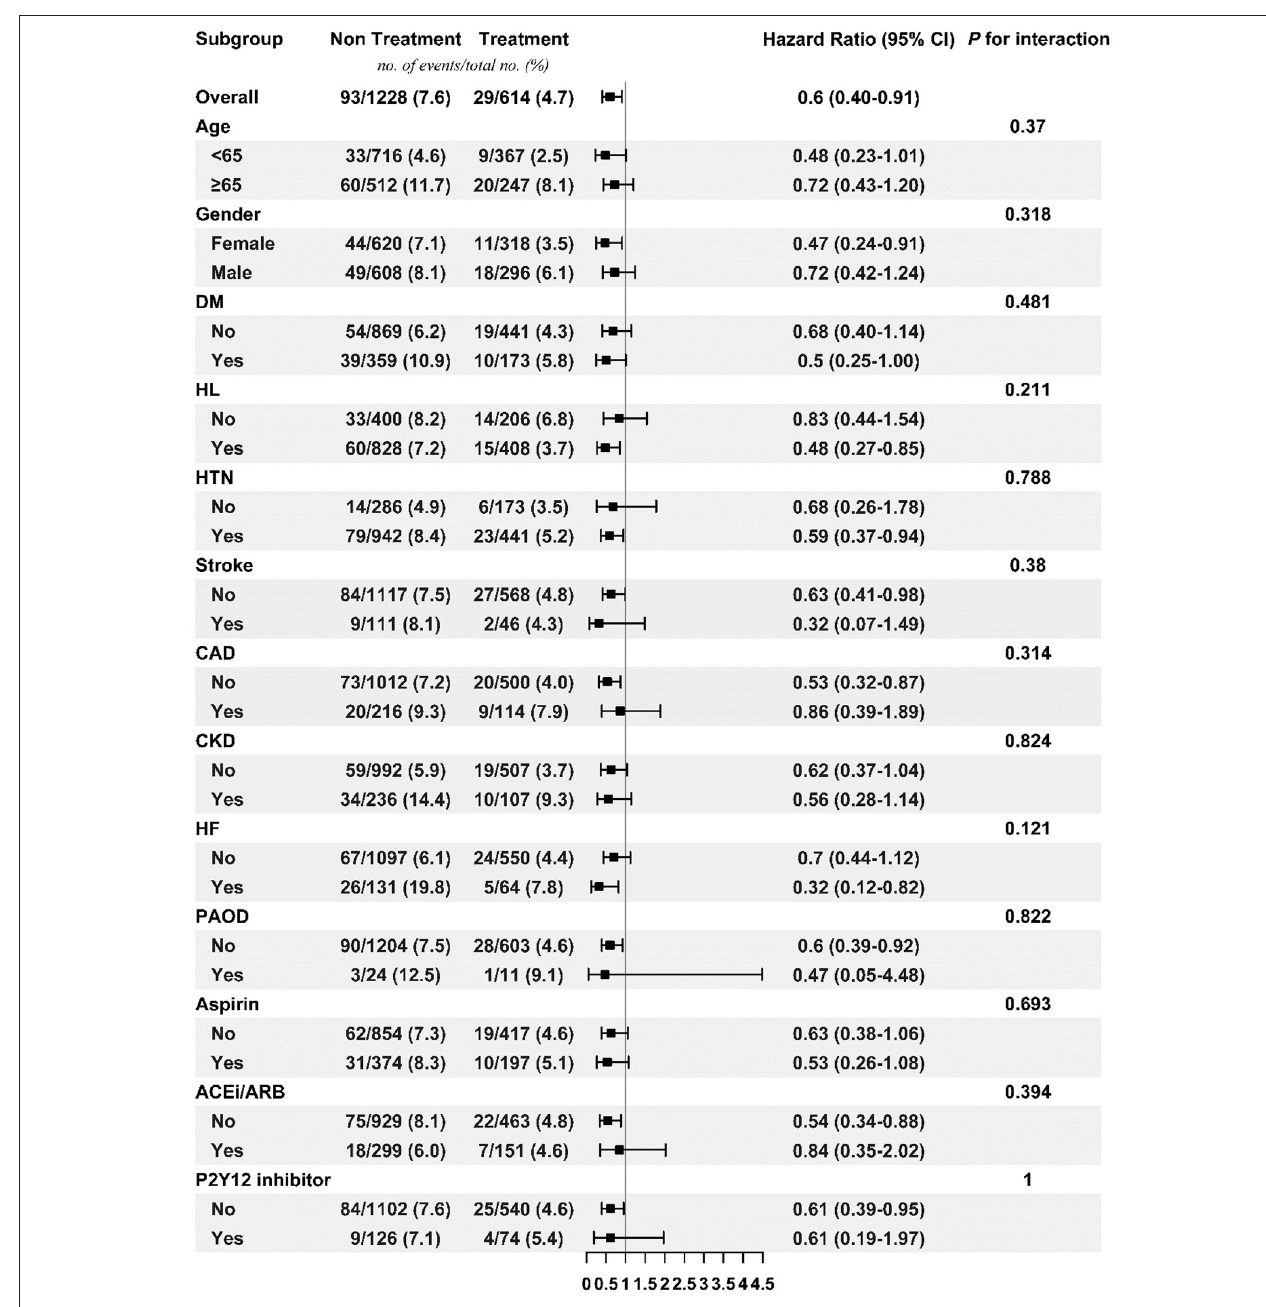
FIGURE 4 | Subgroup analysis of treatment effect on mortality in the low PAC burden sub-cohort. ACEi/ARB, angiotensin-converting enzyme inhibitor/angiotensin receptor blocker; CAD, coronary artery disease; CKD, chronic kidney disease; DM, diabetes mellitus; HF, heart failure; HL, hyperlipidemia; HTN, hypertension; PAC, premature atrial complex; PAOD, peripheral arterial occlusive